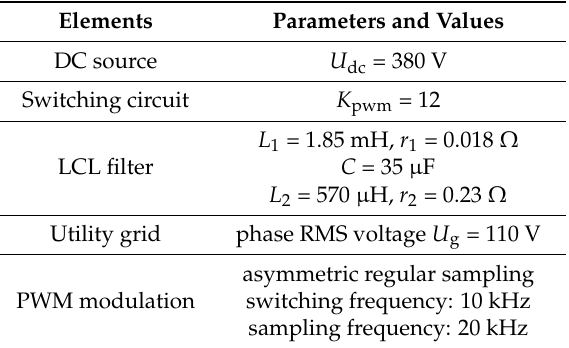
Table 1. Parameters of the system.